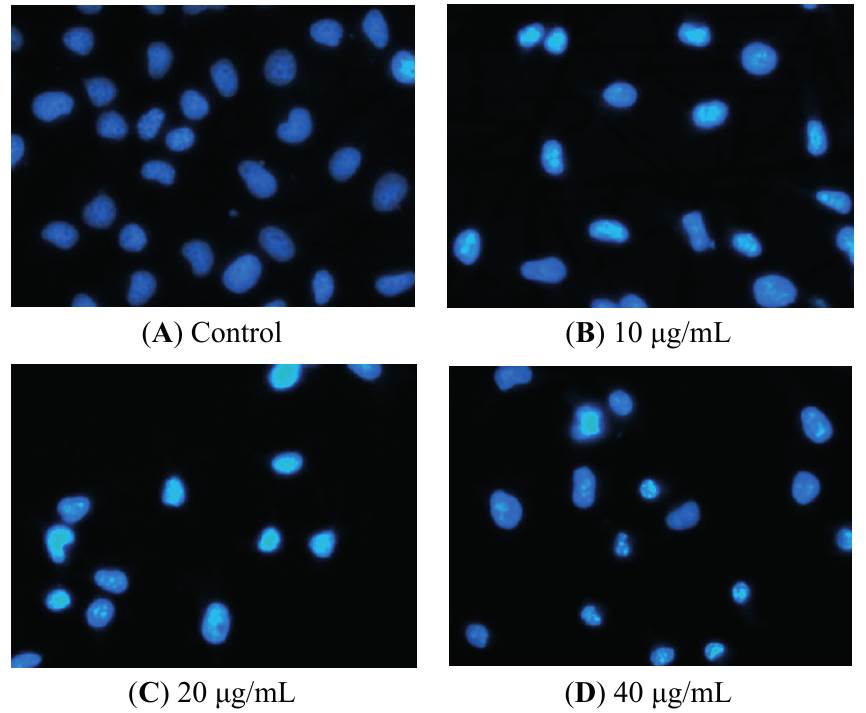
Figure 3. Nuclear morphologic changes in apoptotic HeLa cells by tatariside G. The cells were dyed with Hoechst 33258 after 12 h of treatment with tatariside G (10, 20, and 40 μ g/mL). ( A ) Normal nuclei are symmetrical baby blue. ( B ) Intact nuclei are asymmetrical bright blue in the early stage of apoptosis. ( C ) and ( D ) Fragmented nuclei are presented in the advanced stage of apoptosis. Magnification: 400×.